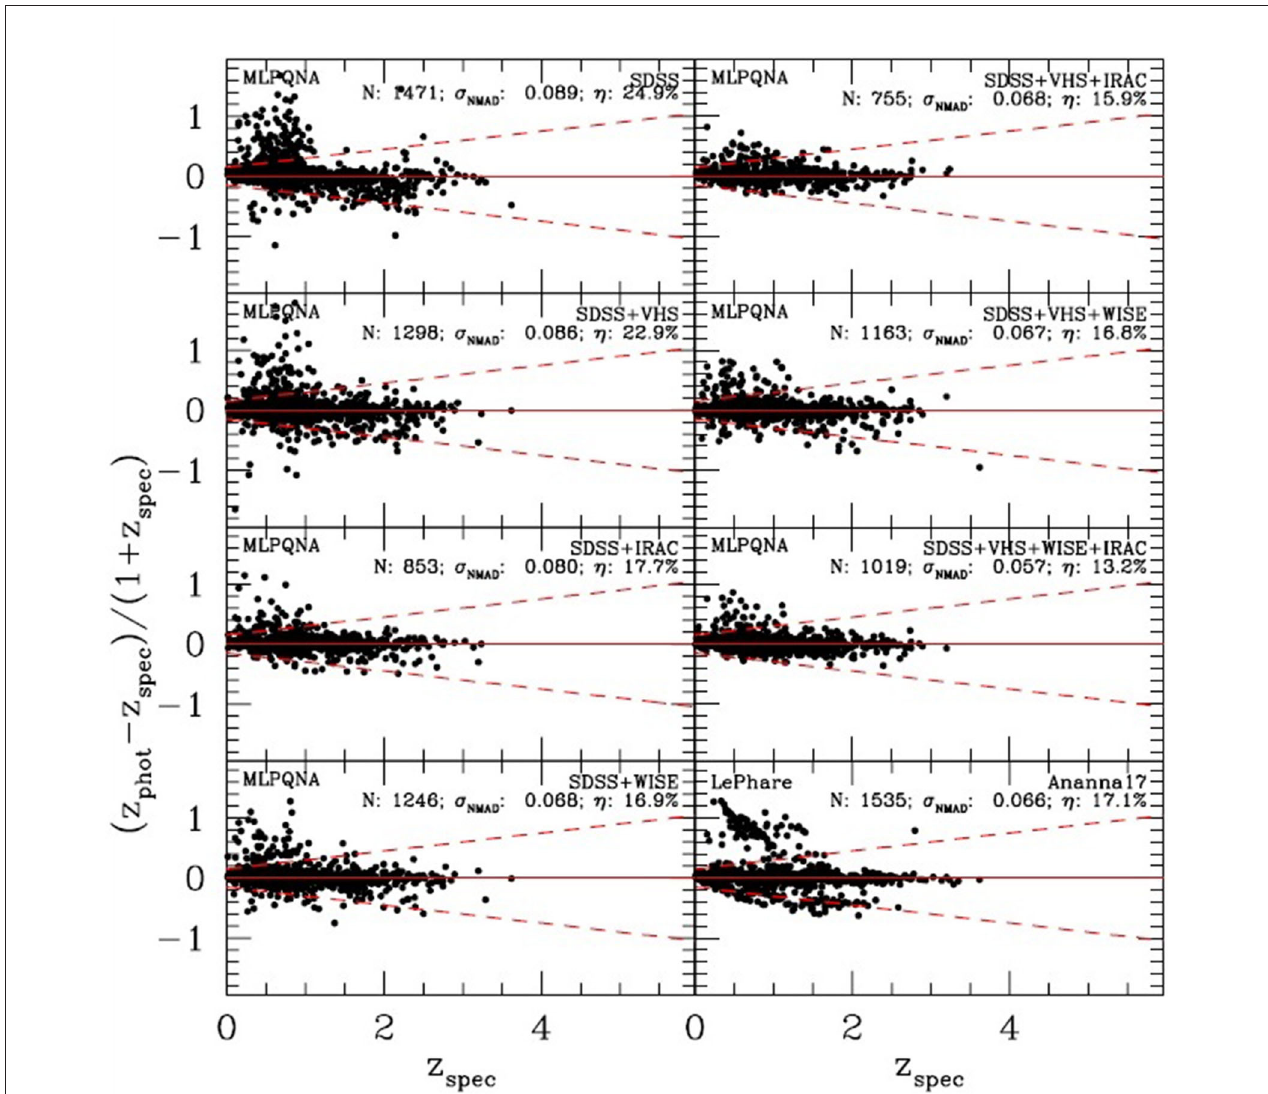
FIGURE 6 | Figure from Brescia et al. (2019). Comparison between spectroscopic redshift and photo-z for the sources cut at the eROSITA flux and divided on the basis of available photometry. For comparison, the result from Ananna et al. (2017) are reported in the lower right panel. By comparing the accuracy and the fraction of outliers in all panels, it appears clearly that using only optical bands for bright X-ray sources is not